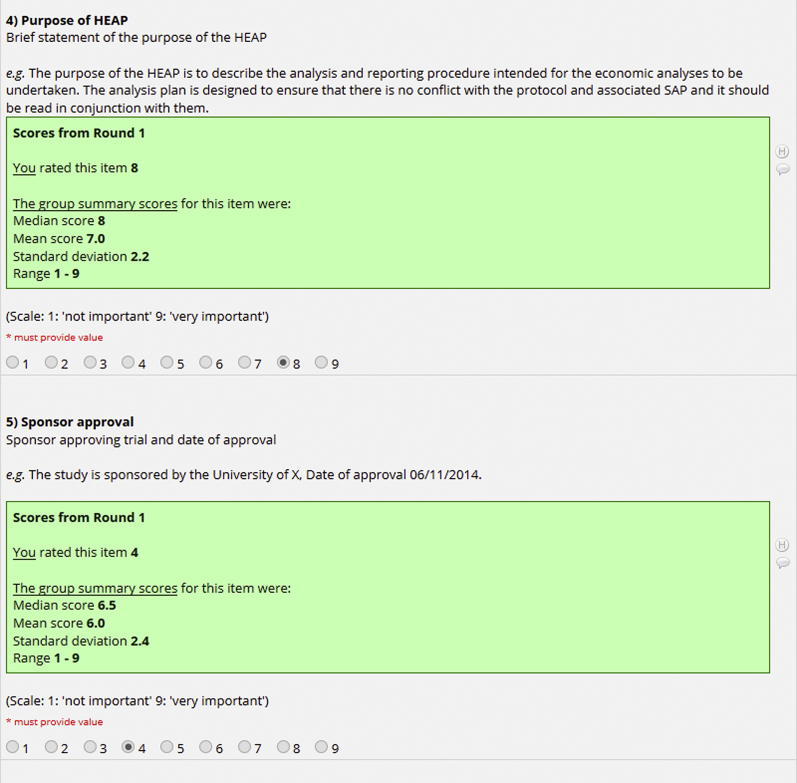
Extract from round 2 of Delphi survey.